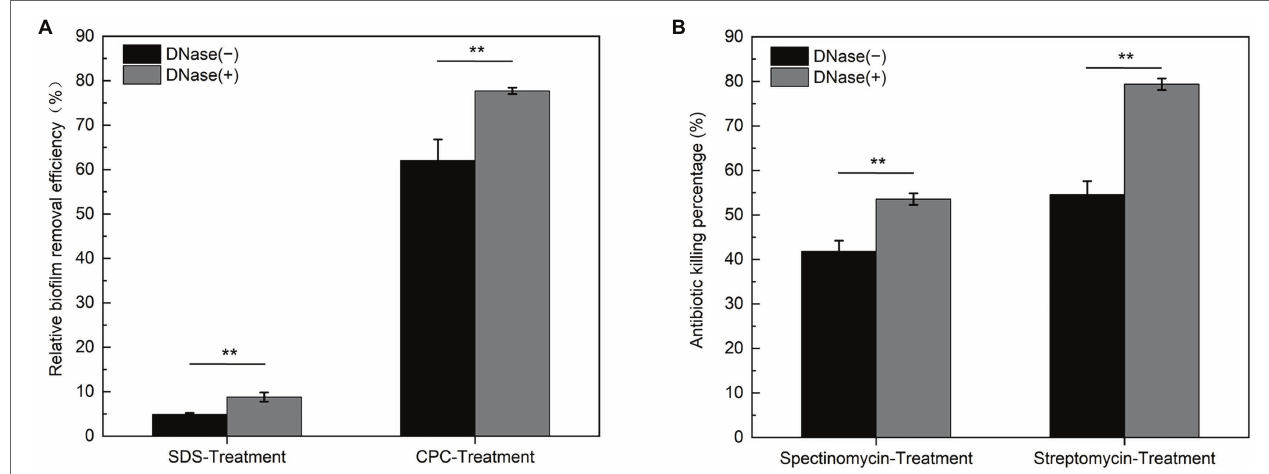
FIGURE 9 | Susceptibility of native and DNase I treated Myxococcus xanthus biofilms to the surfactants and antibiotics. The native (DNase I − ) and DNase I treated (DNase I+) DK1622 non-developmental biofilms were prepared. (A) The relative biofilm removal efficiency was quantified by crystal violet stain after SDS or CPC treatment, respectively. (B) The killing percentage by streptomycin and spectinomycin to the cells within biofilms was determined by colony forming unit (CFU) counting, respectively. ** p < 0.01.